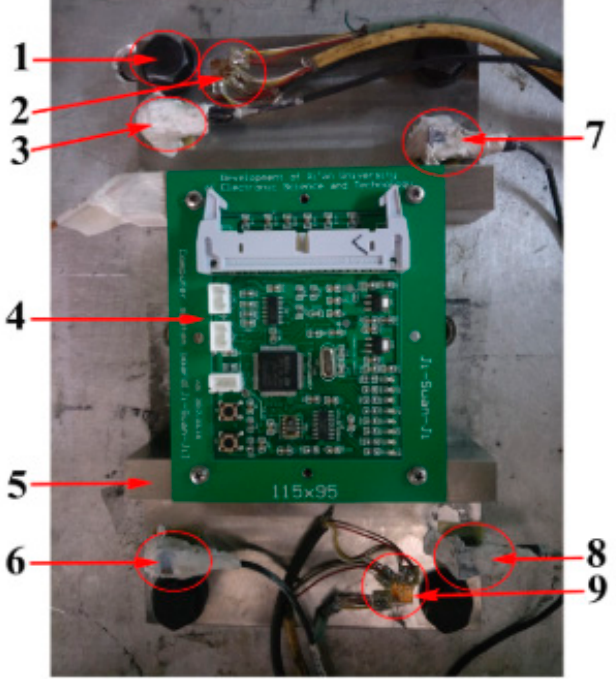
Figure 3. Experimental apparatus for random vibration of the bolted connections [40].